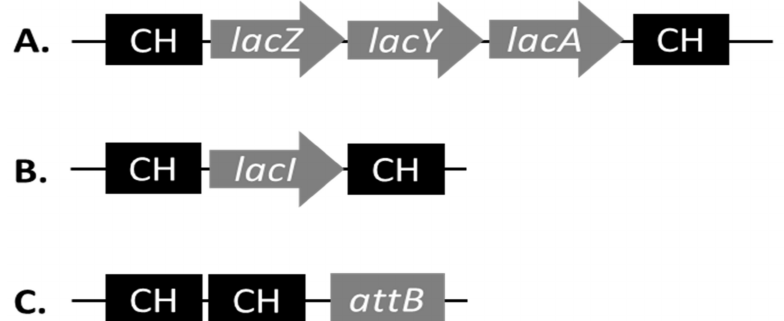
Figure 1. Schematic representation of the positions of chromosomal homology (CH) between EHEC O157:H7 EDL933 and E. coli K-12 MG1655 that were used to design the primers for the recombination substrates. ( A ) CH for the deletion of the lacZYA operon. ( B ) CH for the deletion of the regulatory gene lacI . ( C ) CH for the insertion upstream of the phage lambda attachment site attB